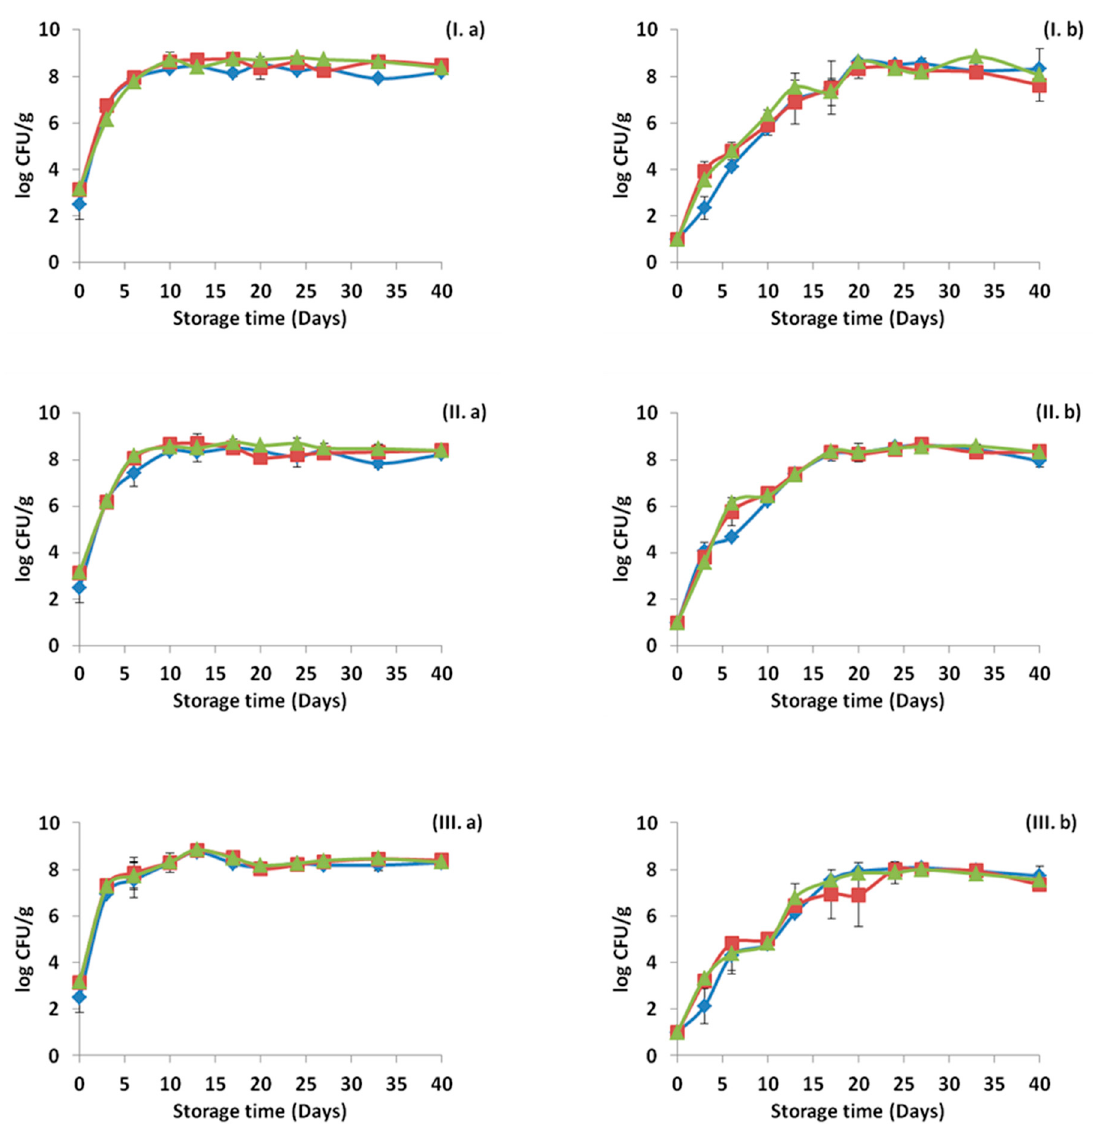
Figure 3. Growth curves of the different bacterial populations in ham stored at 12 °C for the control samples ( I ), samples with edible film free from oregano essential oil-OEOF ( II ) and samples with edible film supplemented with oregano essential oil-OEOS ( III ), without ( a ) and after ( b ) the high pressure processing treatment. ( ♦ ) Lactic acid bacteria, ( ■ ) lactococci/streptococci and ( ▲ ) total viable counts. The bars represent the mean values ± standard deviations.